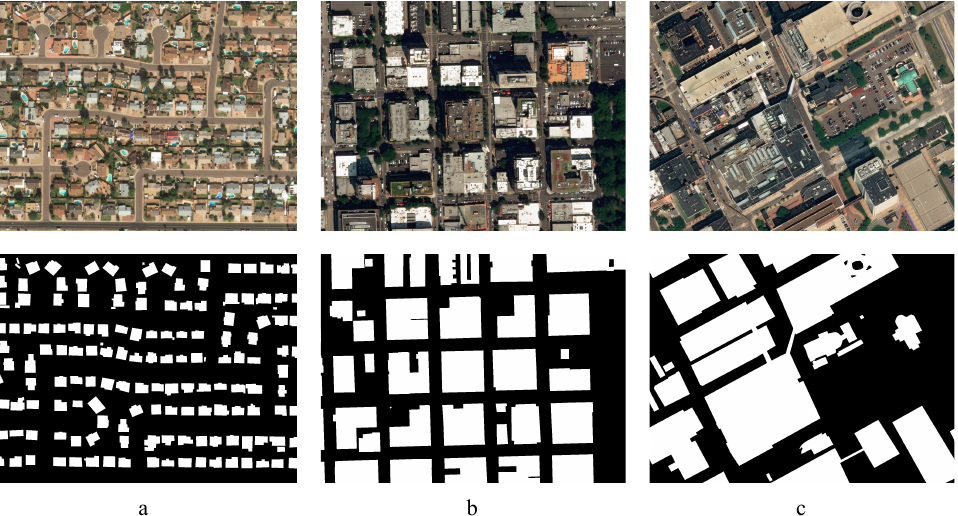
Figure 6. Visual example of buildings with different predominant styles (SFB: single family buildings ( a ), MFB: multiple family buildings ( b ) and IB: industrial buildings ( c